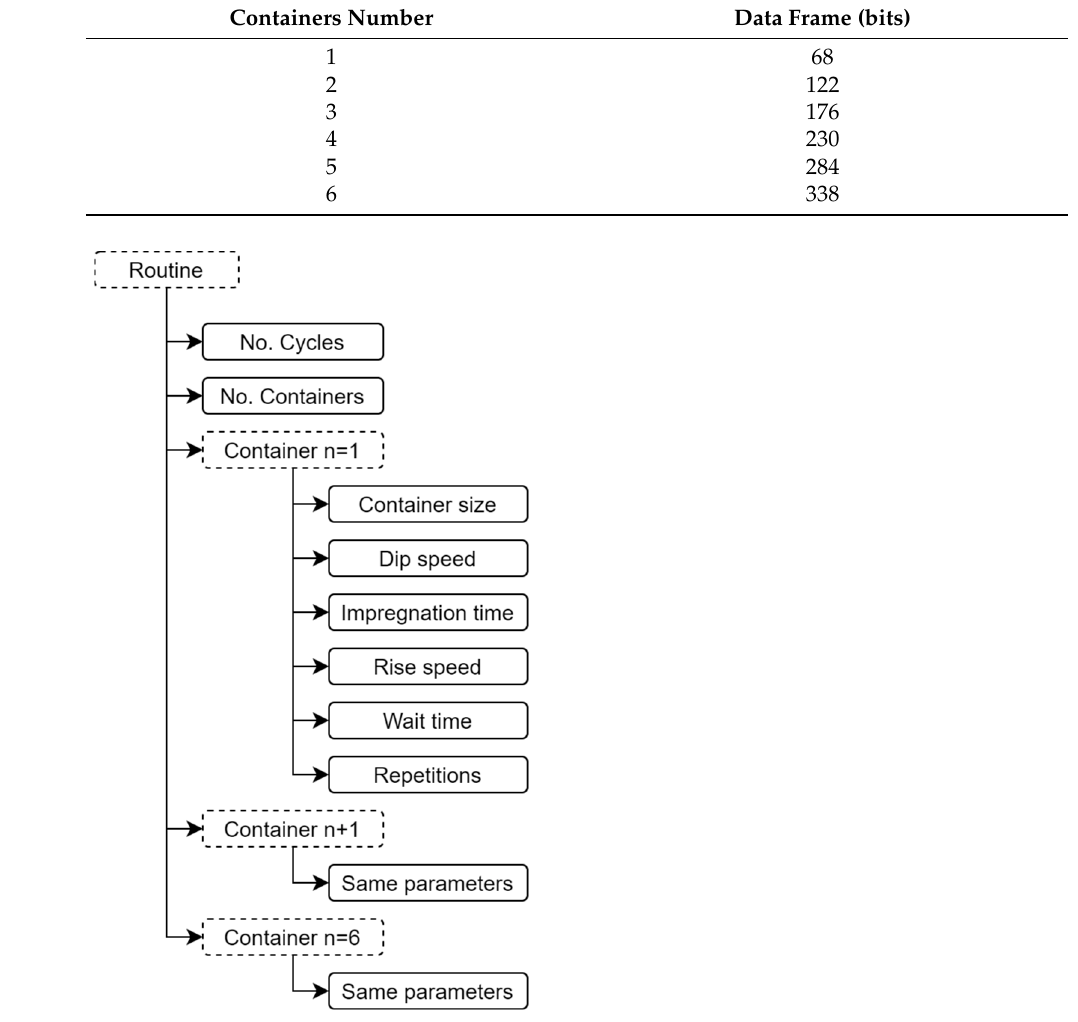
Table 4. Size of the data frame used in the mobile app in function of the number of used containers.